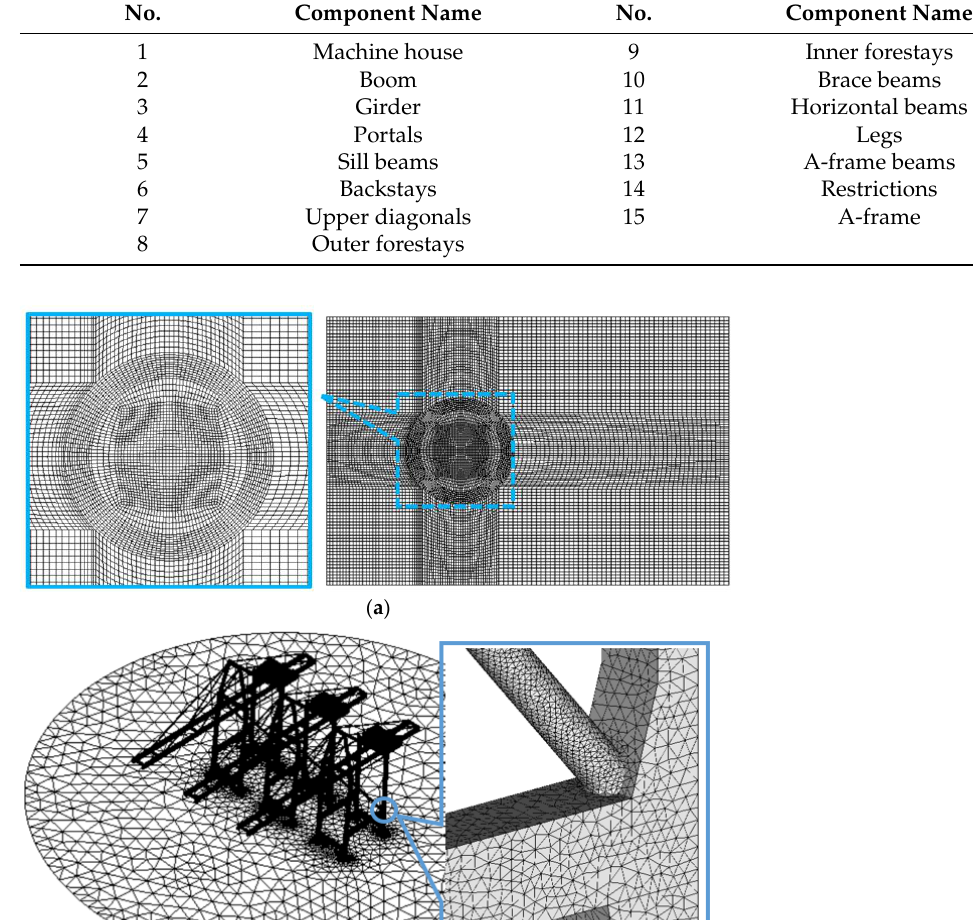
Table 3. Parts of the CFD model.